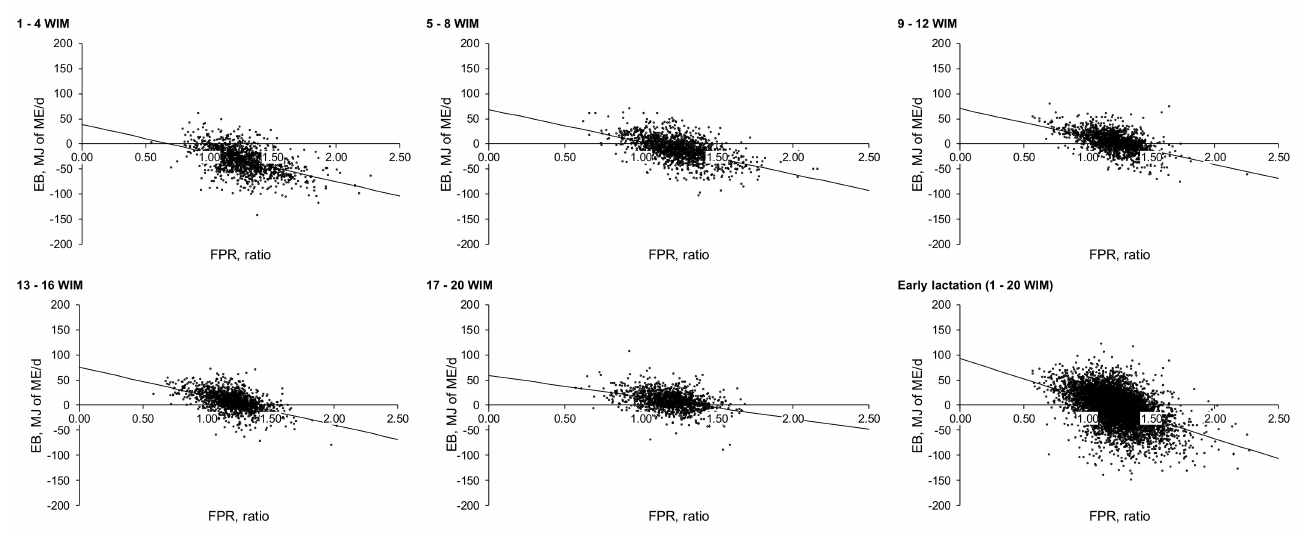
Figure A2. Linear relationships between fat-to-protein ratio in milk (FPR) and daily energy balance (EB, MJ of ME/day) in second lactation Holstein-Friesian dairy cows (1–20 WIM). Mixed regression models for each relationship are presented in Table 3.